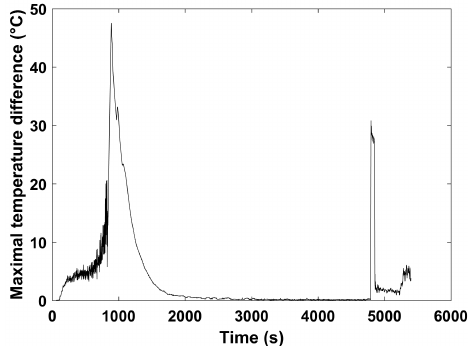
Fig. 3. Development of maximal temperature di ff erence in